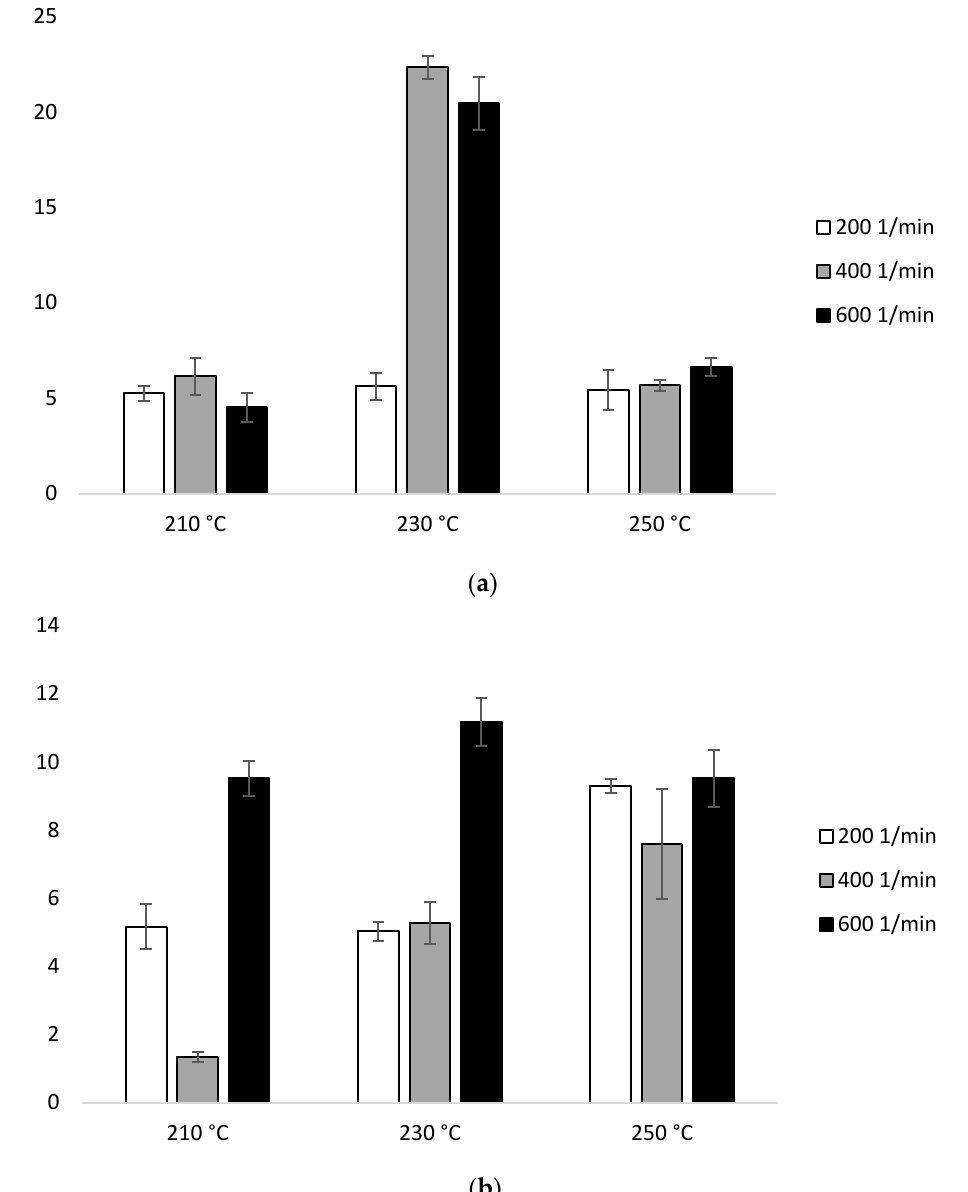
Figure 9. Enthalpy of melting ( Δ H m ) of heating 2: ( a ) configuration 1; ( b ) configuration 2. Abbreviations: as in Table 1.